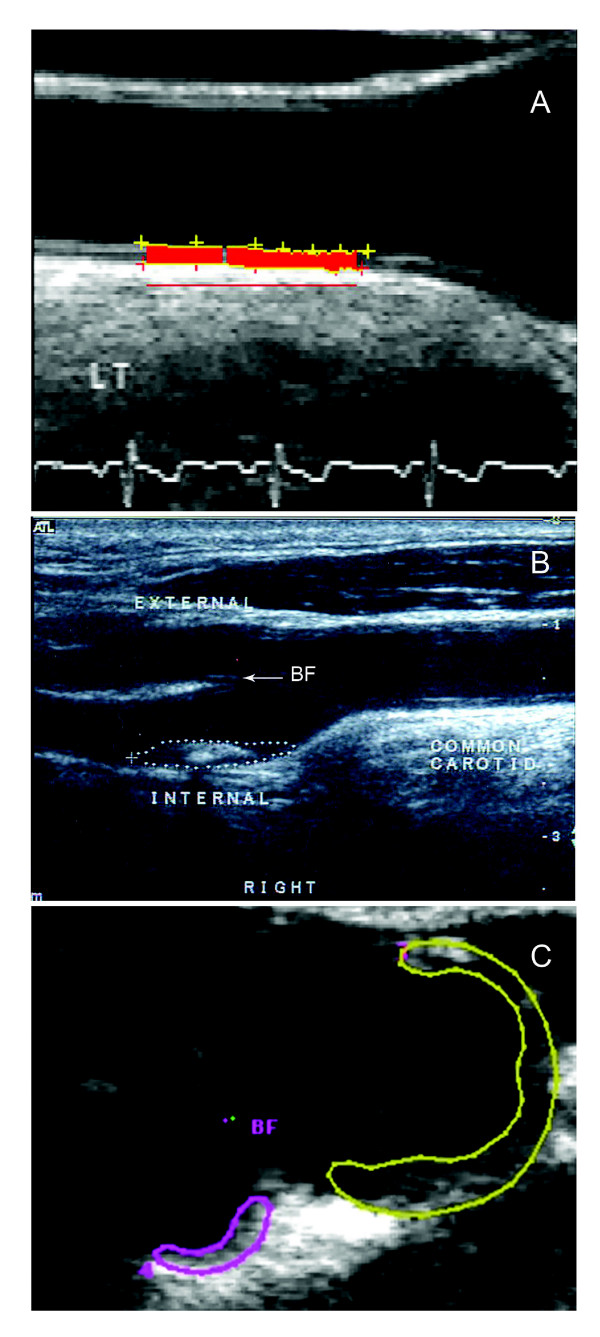
Carotid atherosclerosis imaging phenotypes. A) IMT measurement from a B-mode ultrasound image in the longitudinal view with the carotid bifurcation identified as BF. B) TPA measurement from a longitudinal B-mode US image with the outlined plaque area shown in white. C) cross-sectional or axial view of the internal and external carotid artery with manual TPV measurements in both branches of the artery and the bifurcation marked BF.